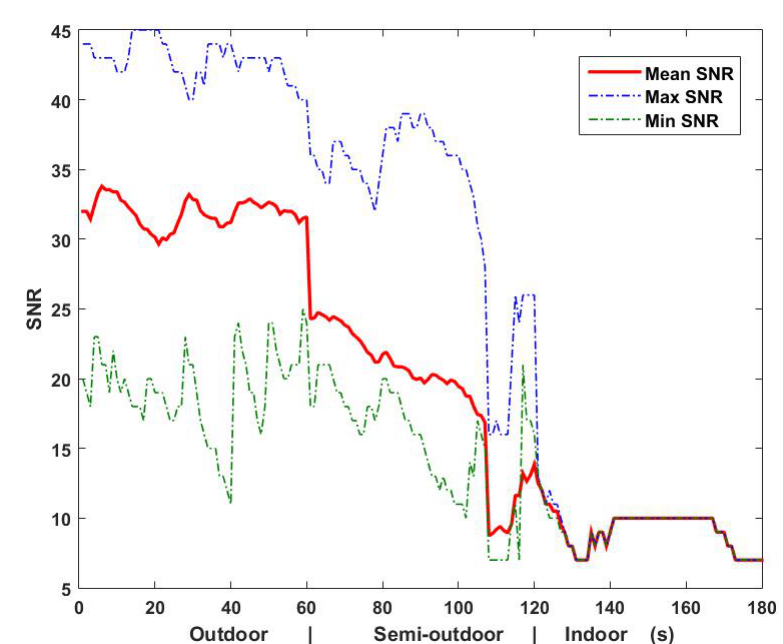
Figure 3. SNR of GPS signals in different